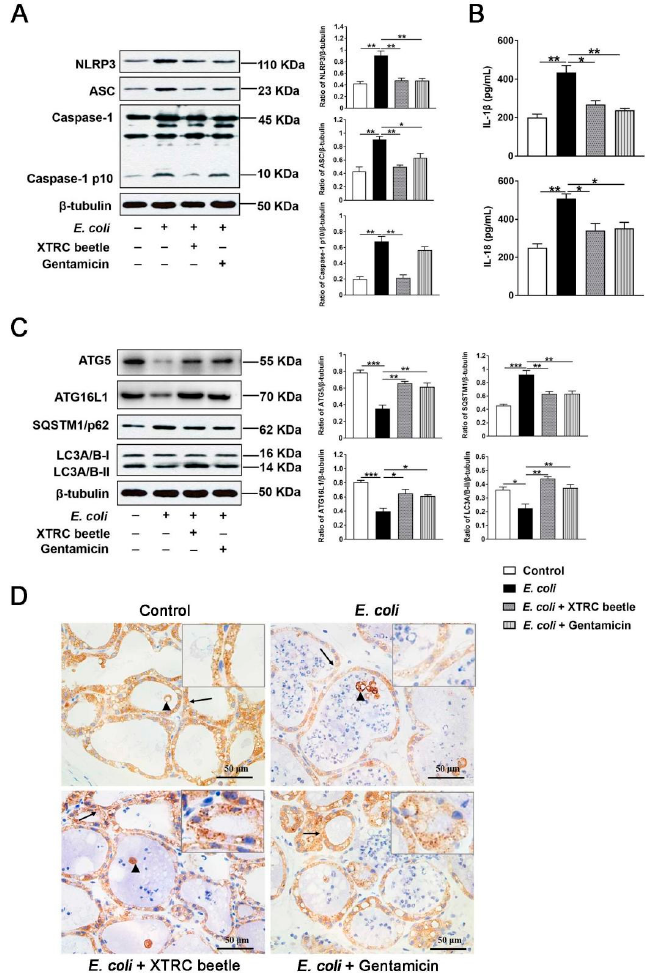
Figure 3. Effect of Z. morio hemolymph on the NLRP3 inflammasome and ATG5/ATG16L1-mediated autophagy signaling pathway in E. coli -induced mastitis. ( A ) Protein levels of NLRP3, ASC and Caspase-1 was measured using western blotting analysis. The right panel shows the protein quan- tification using ImageJ software (version 1.50). ( B ) Levels of IL-1 β and IL-18 were measured by ELISA. ( C ) Protein levels of ATG5, ATG16L1, P62 and LC3A/B-II was measured using Western blotting analysis. The panel shows the protein quantification using ImageJ software (version 1.50). ( D ) Relative quantification and localization of LC3A/B-II (brown-yellow dots) expression by IHC. Black arrows indicate LC3A/B-II localized in the cytosol of MECs, black triangles indicate LC3A/B-II localized in the cytosol of MECs that exfoliated into the acinar lumen. XTRC beetle stands for Z. morio hemolymph-treatment. Data presented are means ± SEM ( n = 8 per group). * p < 0.05, ** p < 0.01, *** p <